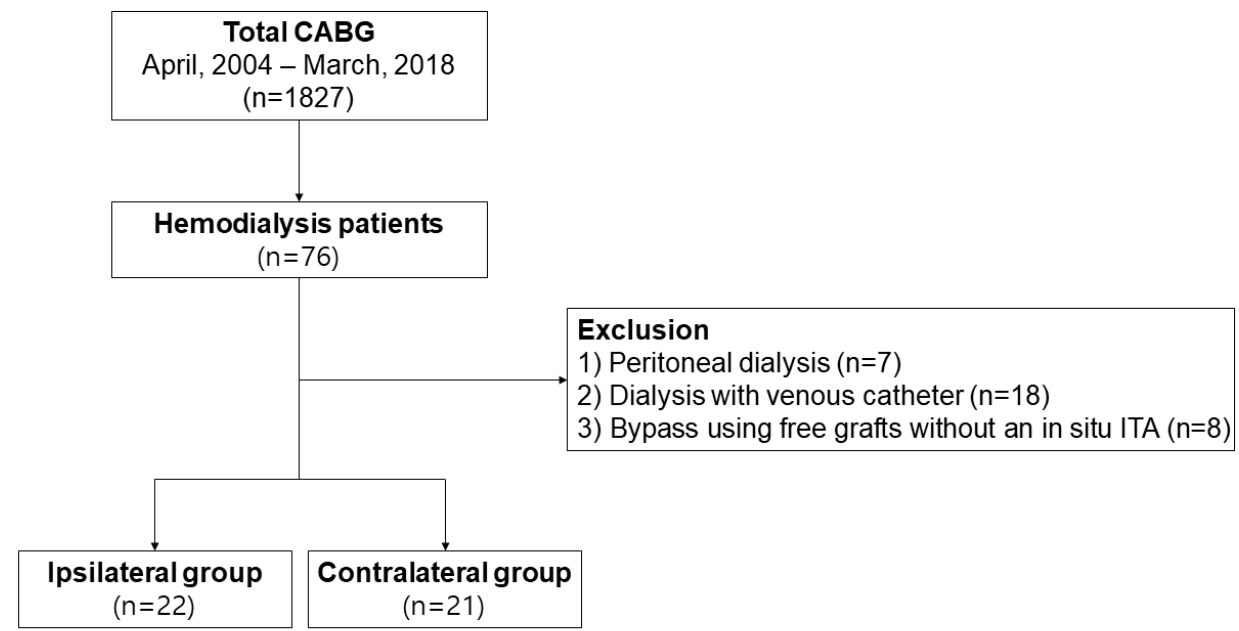
Figure 1. A diagram showing patient